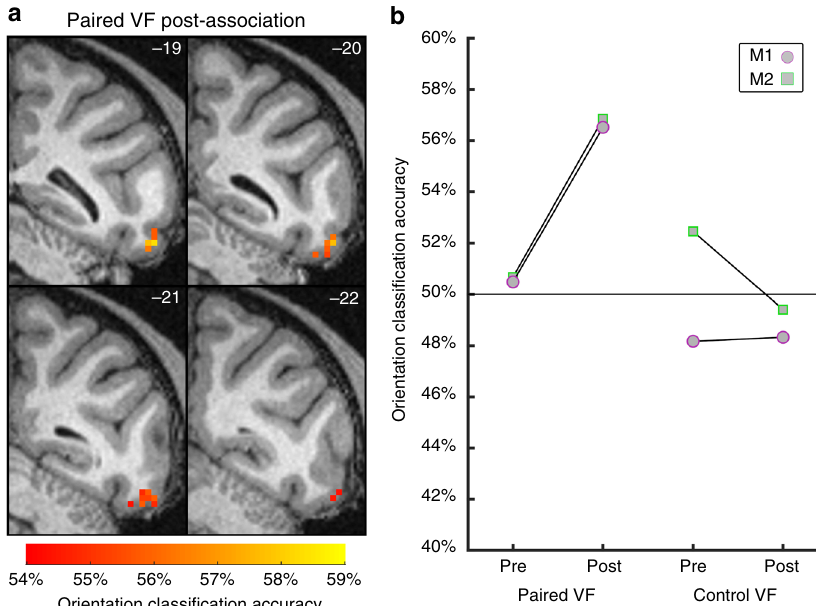
Fig. 3 Experiment 1: VTA microstimulation selectively enhances stimulus information. A searchlight analysis (sphere of 20 voxels) using a naive Bayes classi fi er 73 was performed across all voxels in retinotopic visual areas (V1 — PITv, see Methods). Searchlight analyses were performed separately for the pre- and post-association phases, the paired and control VFs and for each monkey (M1 – 104 runs per phase; M2 – 78 runs per phase). A cluster-corrected permutation test ( p < 0.05, cluster size = 25 voxels, see Methods) on the conjunction of M1 and M2 data was used to determine signi fi cance. a Signi fi cant orientation classi fi cation accuracy for the paired VF in the post-association period is depicted on coronal slices (mm relative to inter-aural line denoted in top right). b Mean orientation classi fi cation accuracy within signi fi cant PITv cluster found from searchlight analysis of paired VF post-association data. Black line denotes mean orientation classi fi cation accuracy for the group. The purple circle and the green square with lines displays the mean orientation classi fi cation accuracy for M1 and M2,